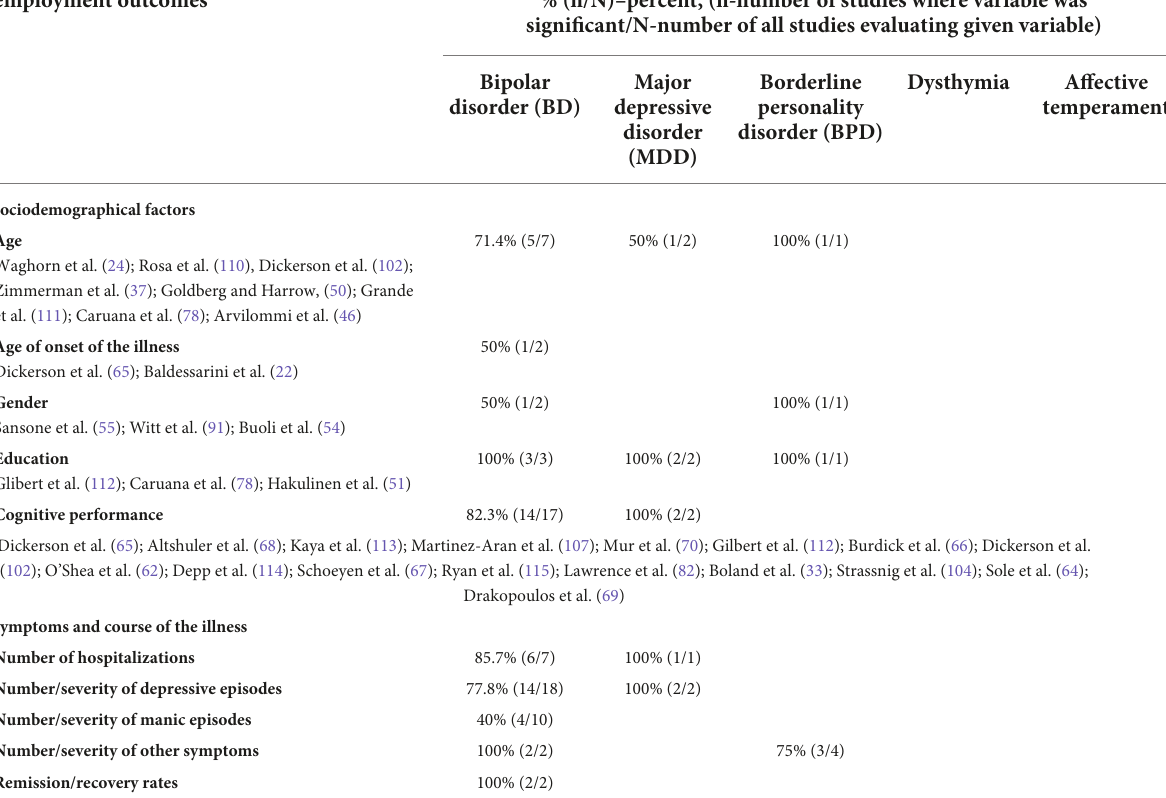
TABLE 2 Factors associated with employment outcomes in individuals with BS disorders. Factors significantly associated with employment outcomes